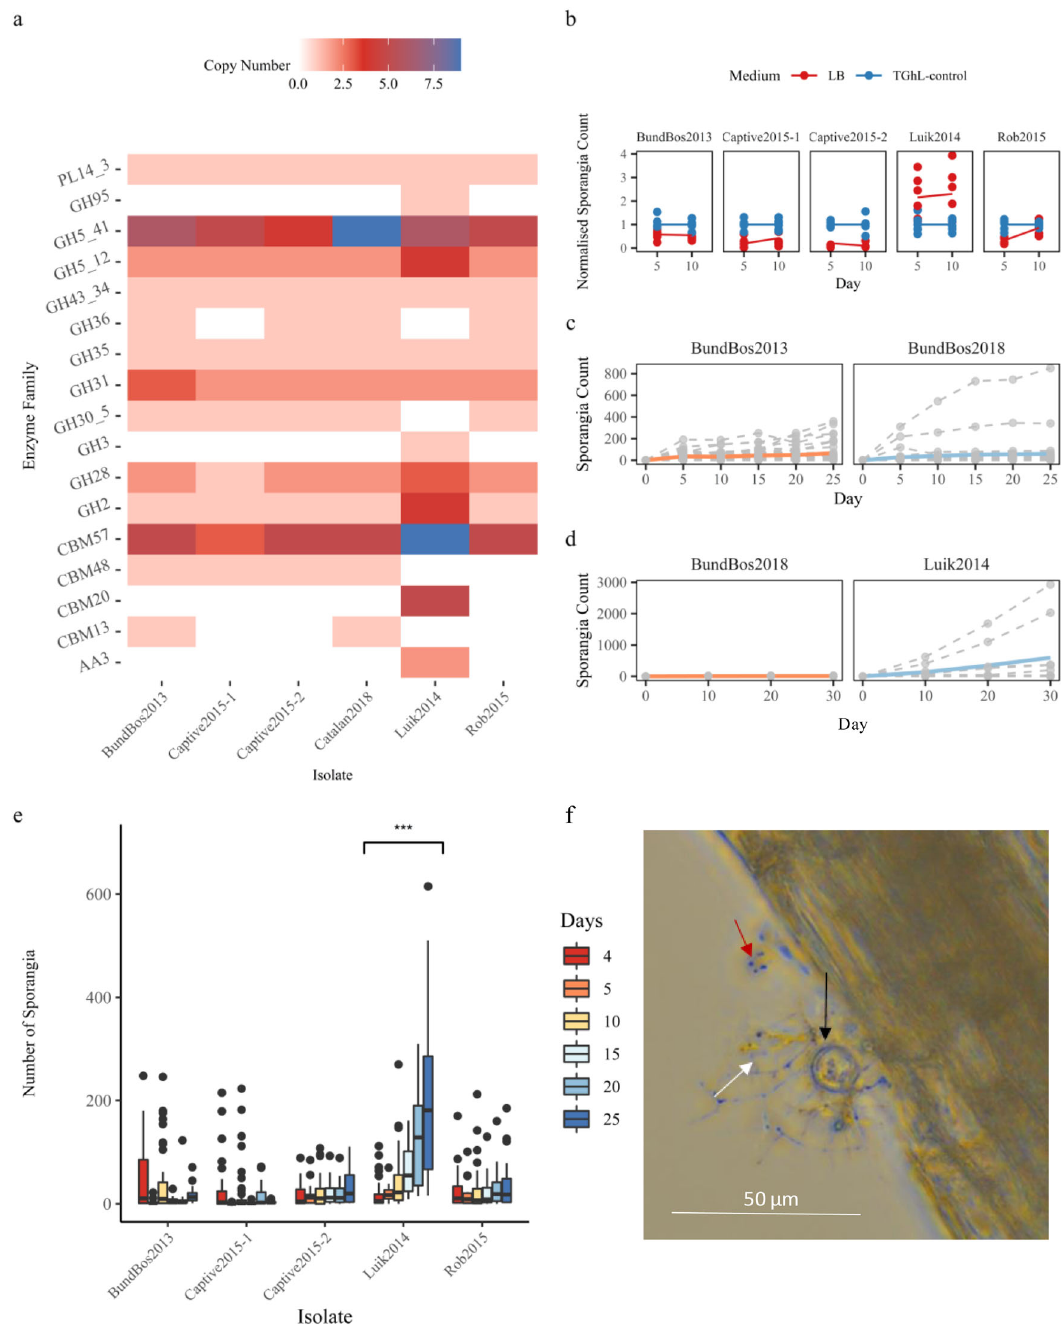
Fig. 3 Intraspeci fi c differential vegetative metabolic capacities. a Heatmap displaying copy numbers of enzyme families associated with metabolising plant carbohydrates; b scatterplot of sporangia counts in cultures grown in lima bean (LB) medium (red) vs optimised conditions of TGhL medium (blue), normalised for each isolate and time against the average count for the optimised TGhL medium, with the average for each condition, isolate and time represented by a solid line; c Line graph of counts of mature sporangia visualised attached on each sample of plant material at days 5-25 for BundBos2013 and BundBos2018, solid line depicts average d growth plots of Luik2014 and BundBos2018 on autoclaved beech leaf material, dashed lines represent each individual sample, solid line represents averaged count. e Box plot representing counts of mature sporangia visualised attached on sterilised hay plant material at days 4 – 25 per isolate. Boxplots constructed with the centre representing the median, the bounds of the box representing 25th and 75th percentiles, whiskers representing the biggest or smallest value within 1.5× interquartile range of 25th/75th percentiles and data points outside this as outlier points. Signi fi cant increase in sporangia count over time, compared to other isolates, indicated by three asterisks as p < 0.001 (Wald Test p = 5.73e − 13, n = 230 (46 biologically independent replicates per isolate across 4 experiments)). f Light microscopy of BundBos2018 sporangia attached to autoclave hay material (20× magni fi cation), photograph taken 327 days after introduction of spores to material, black arrow indicates sporangia, white arrow indicates rhizoids that are extensive compared to in culture, red arrow indicates small new sporangia in which moving spores could be visualised.